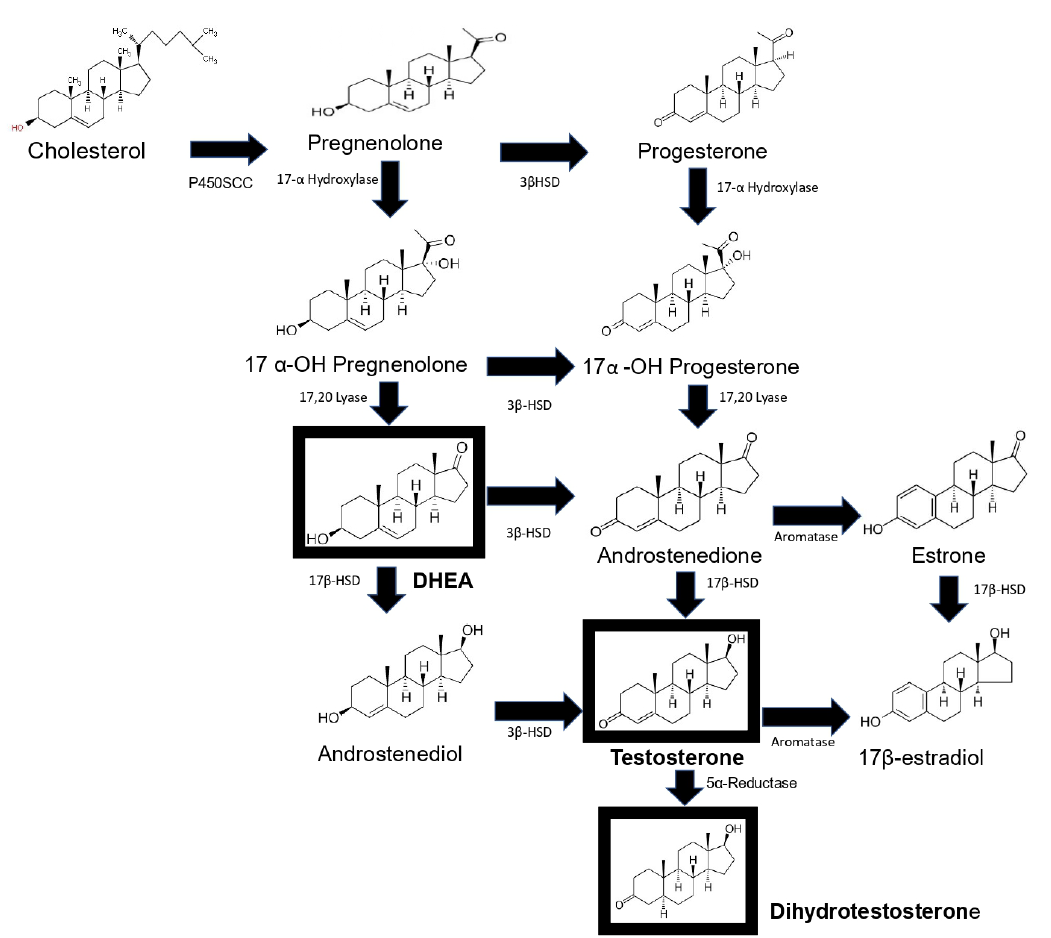
Figure 1. Schematic representation of androgen synthesis. Steroidogenesis starts with the cleavage of cholesterol by the P450SCS enzyme, which transforms it into pregnenolone, which is hydroxylated at carbon 17 by 17 α -hydroxylase; the resulting product is the hormone DHEA. DHEA is converted to androstenediol by the enzyme 17 β -HSD. This steroid and androstenedione are transformed to testosterone by the enzymes 3 β -HSD and 17 β -HSD, respectively. Dihydrotestosterone (DHT) is synthesized from testosterone. Finally, androstenedione is converted into estrone by the enzyme aromatase and estrone into 17 β -estradiol by 17 β HSD, and testosterone is transformed into 17 β -estradiol by aromatase. The main sex hormones are highlighted in a box. This image based on the text described in [12].